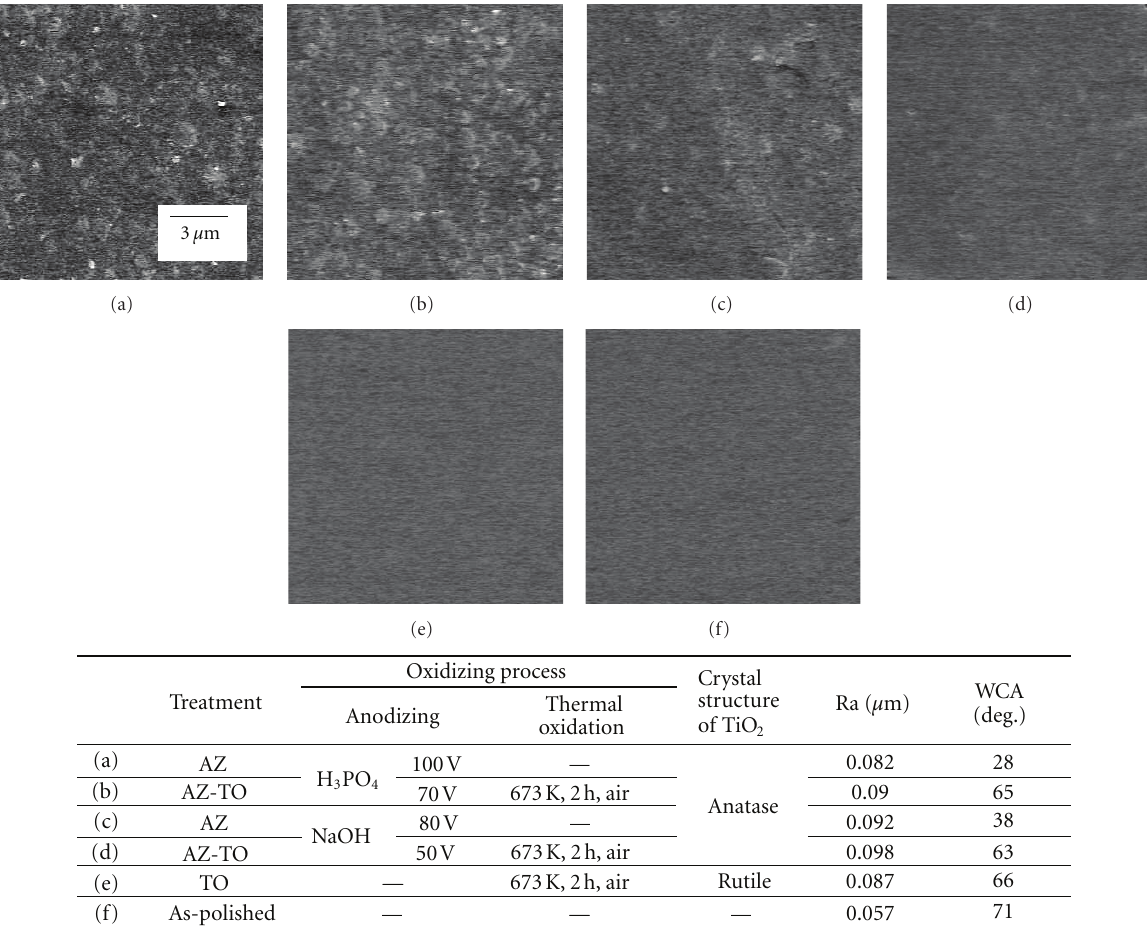
— —— — — Figure 1: The surface SEM images, surface roughness Ra, and WCA of the samples prepared in this